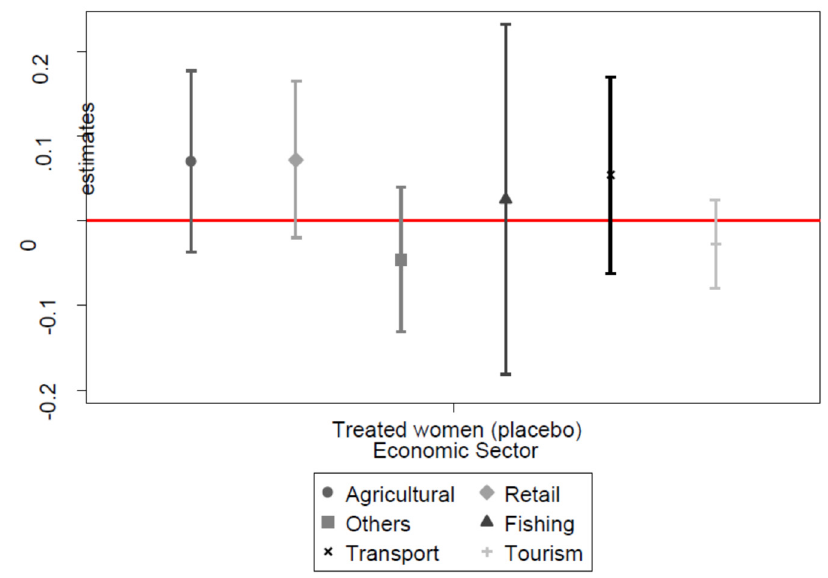
Figure 3. Placebo—Loans Granted by Economic Sector (pp). Figure 3. Placebo - Loans Granted by Economic Sector (pp).